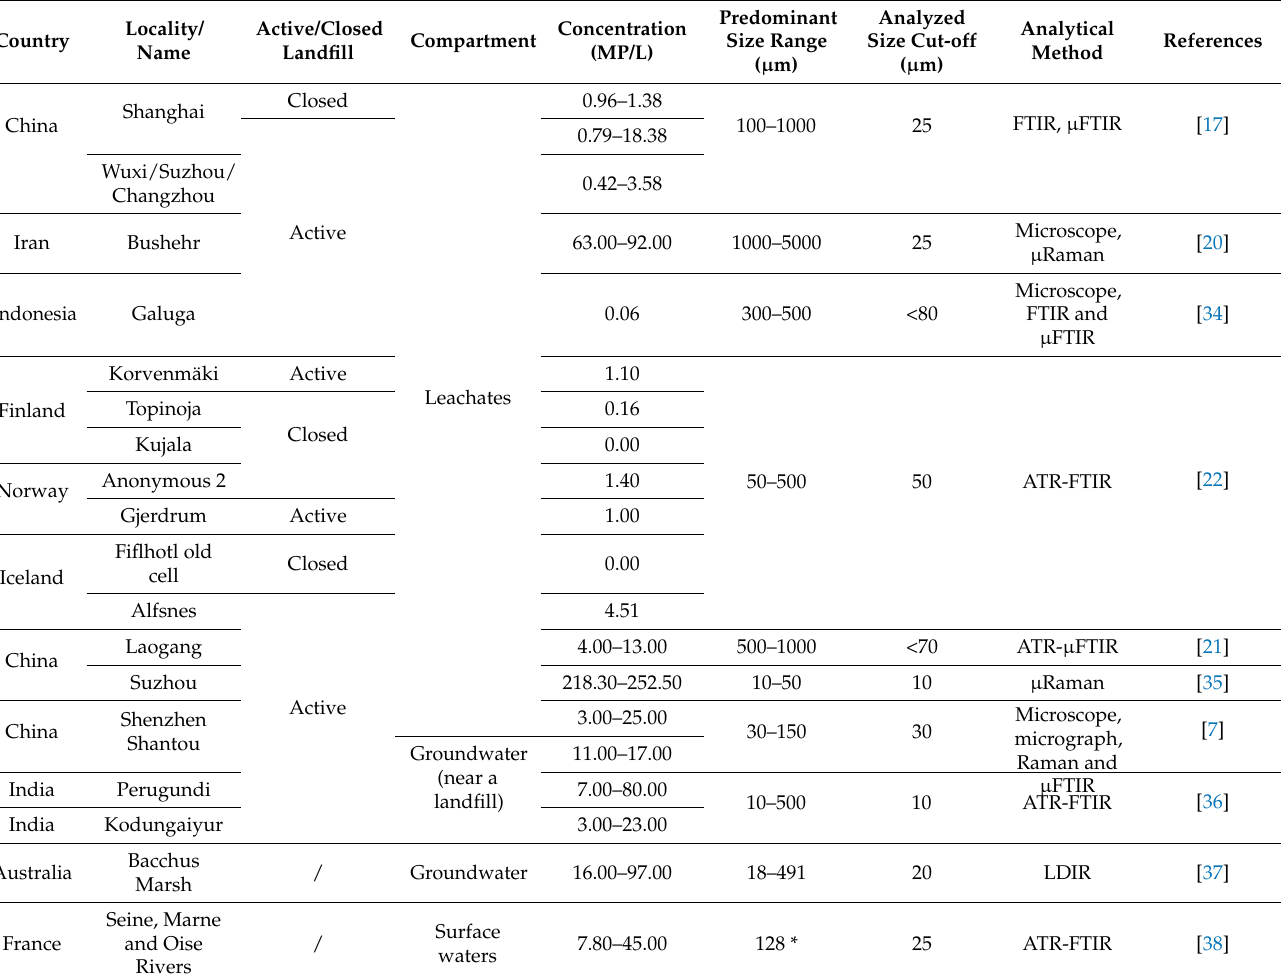
Table 1. MP concentrations and size ranges in different geographical locations and environmental compartments. * Median size